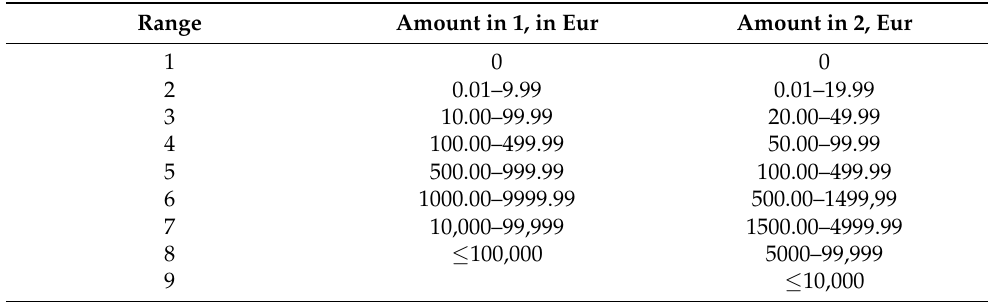
Table 5. Subdivision into the ranges: the amount within the range is treated as a similar financial operation.